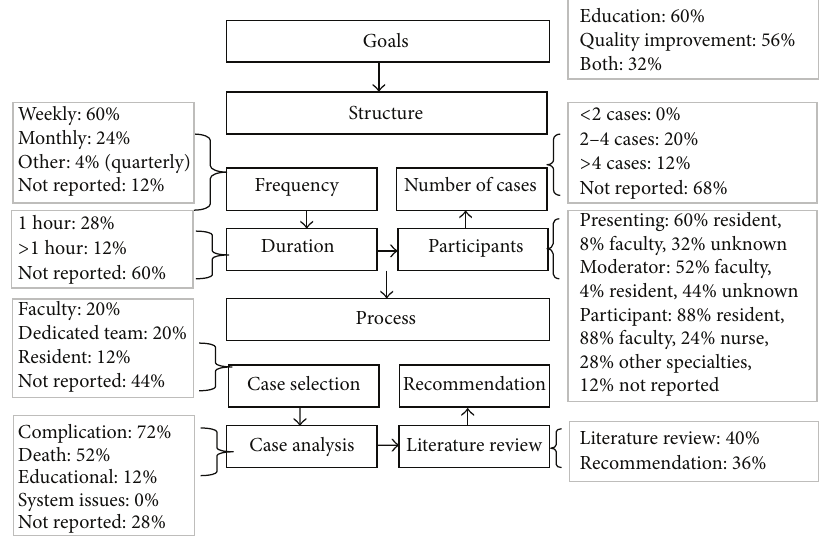
Figure 4: Characteristics of MMC in surgery ( 𝑛 = 25 , percentages not mutually